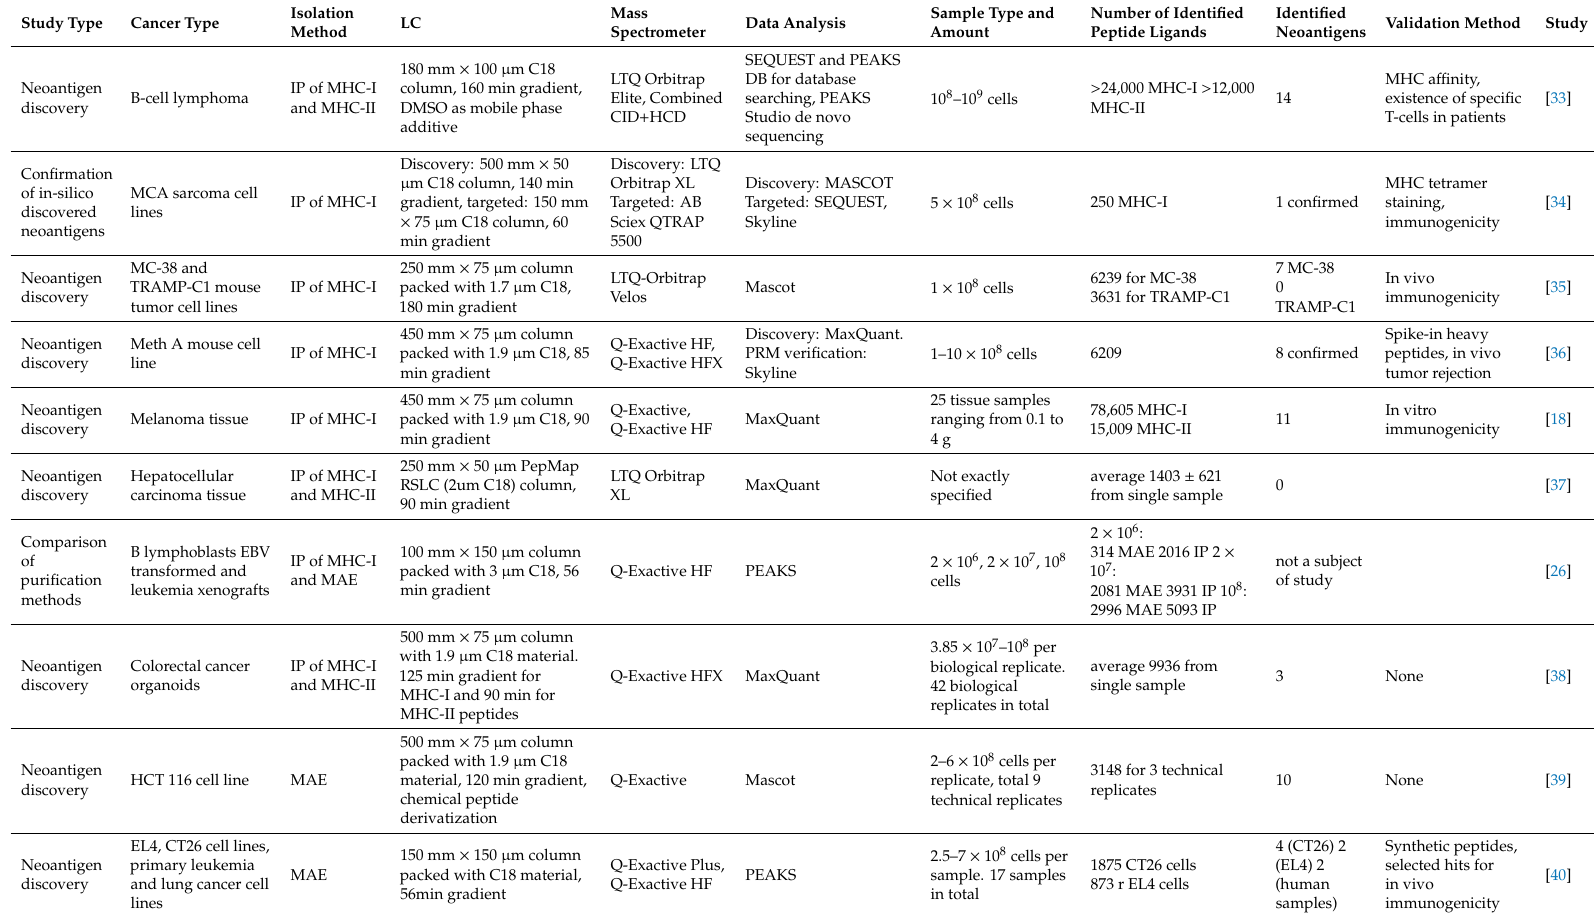
Table 1. Summary of selected immunopeptidomic studies and their comparison in terms of isolation method and instrumental detection. EBV—Epstein-Barr virus DMSO—dimethyl